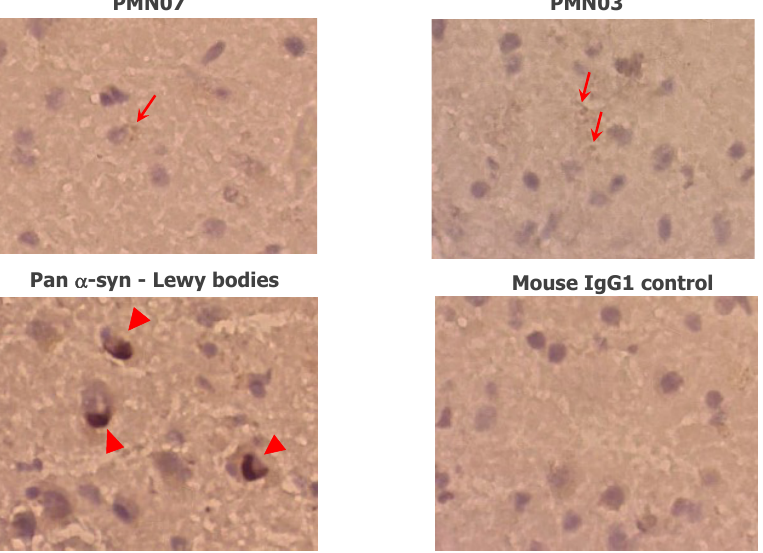
Figure 6. Reactivity of mAbs with DLB brain sections. mAbs show occasional staining of small aggregates ( arrows ) as opposed to the dense insoluble deposits of α -syn in Lewy bodies stained by a pan α -syn reactive antibody ( arrowheads ). No staining is seen with a mouse IgG1 negative control. Images are representative of the staining pattern seen with 17 mAbs tested. Magnification: 40×.